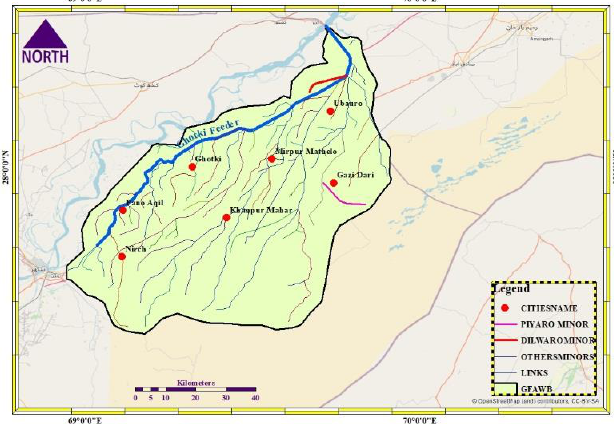
Figure 1: Layout base map of Piyaro minor and Dilwaro minor in Ghotki feeder canal area water board